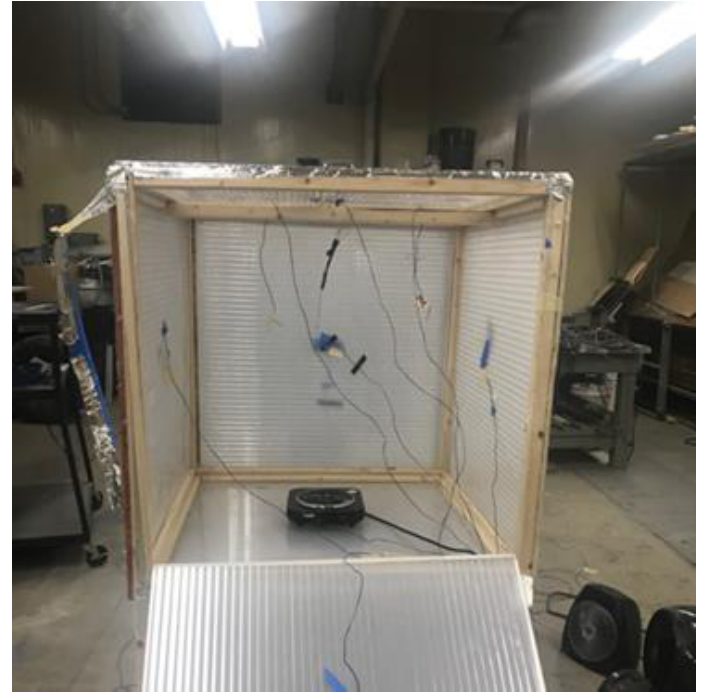
Figure 5. Aerogel box for experimental validation.